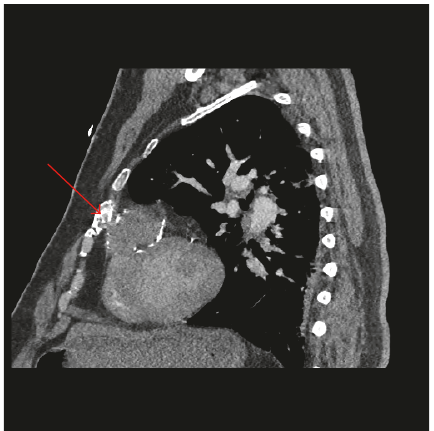
Figure 7: CT pulmonary angiogram. An old healed rib fracture anterior to the pseudoaneurysm (red